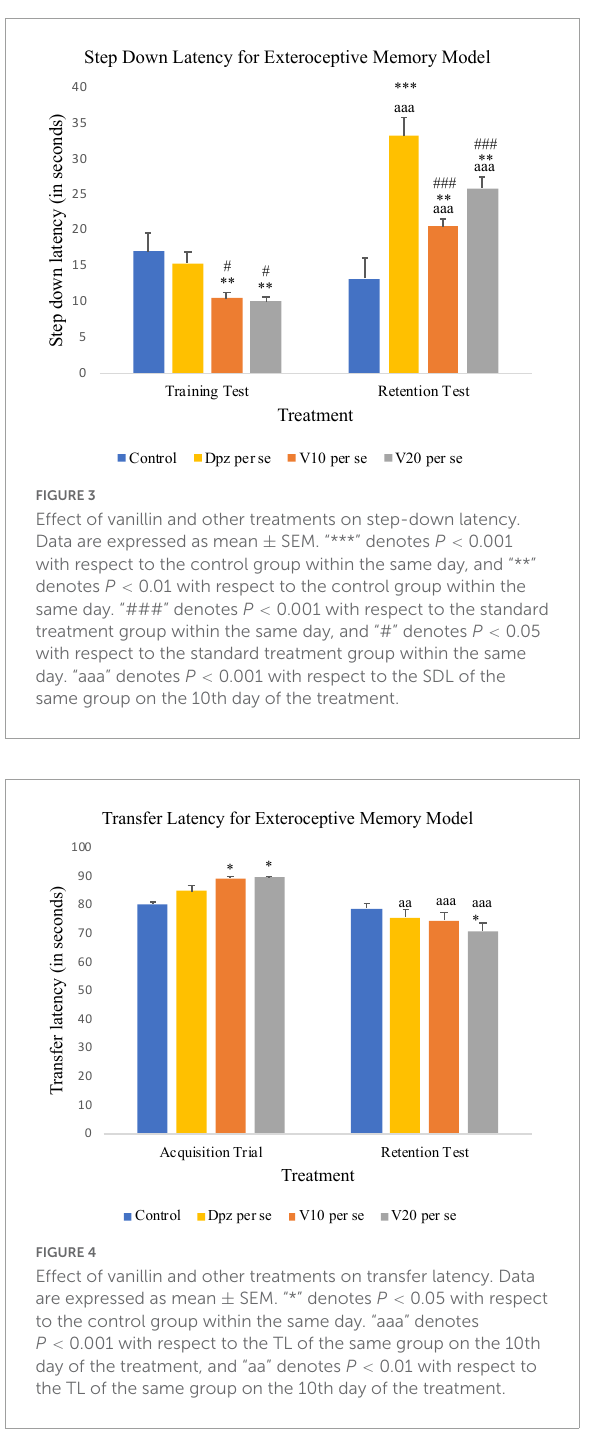
than the control group receiving only normal saline. Vanillin- treated groups V 10 per se (receiving vanillin 10 mg/kg) and V 20 per se (receiving vanillin 20 mg/kg) exhibited a significantly ( P < 0.001) lower EL than the control group. The EL of the V 20 per se group was significantly ( P < 0.001) lesser than that of the Dpz per se